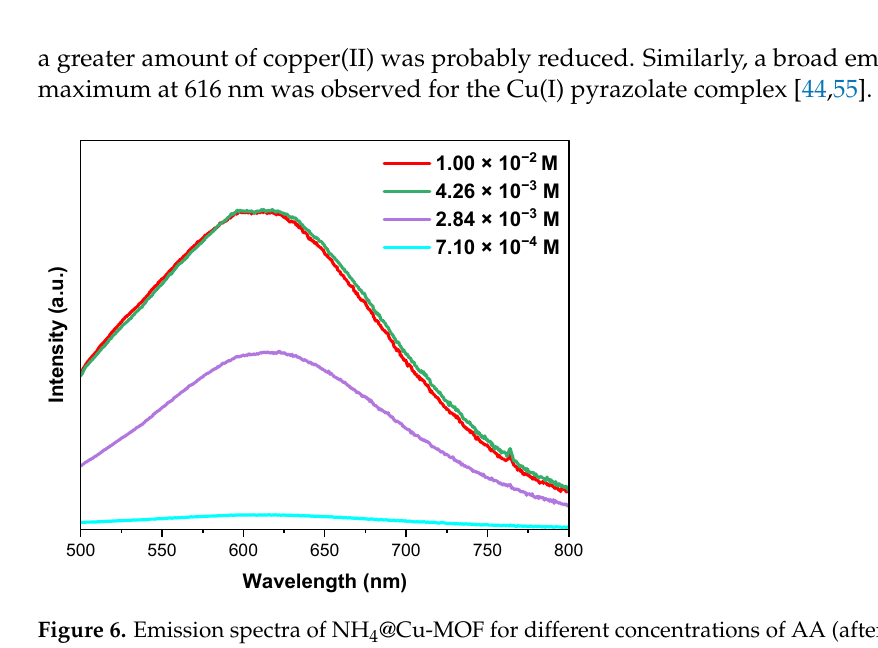
Figure 6. Emission spectra of NH 4 @Cu-MOF for different concentrations of AA (after treatment for 15 min, λ exc = 330 nm).